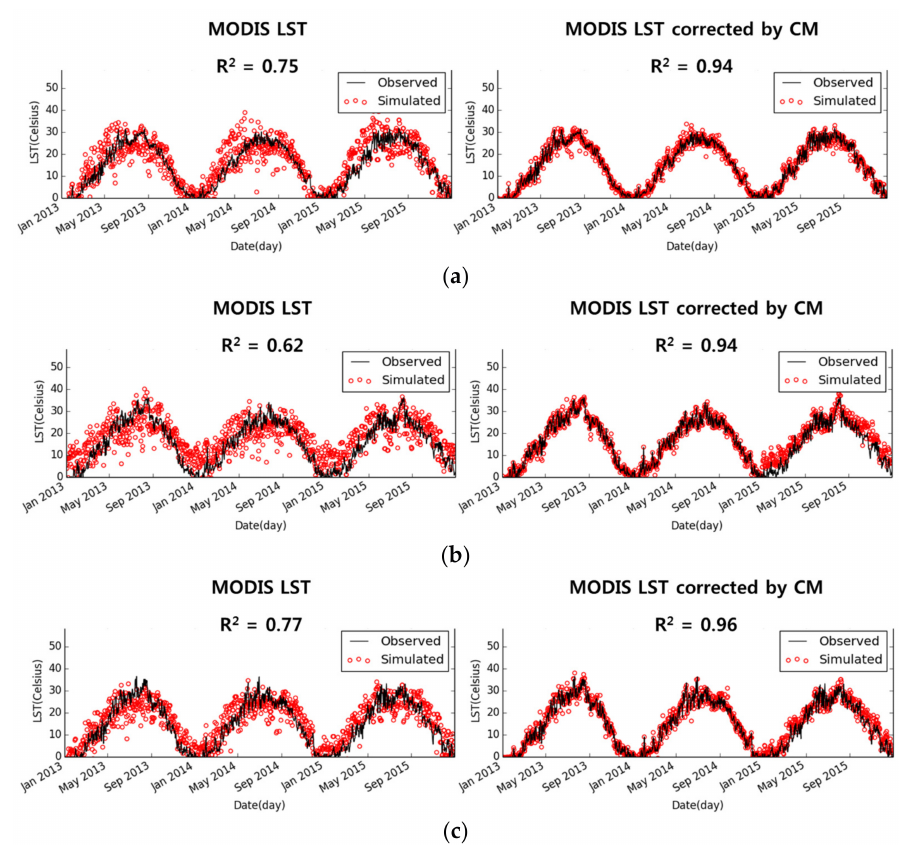
Figure 6. Comparison of observed and simulated LST graphs at verified stations: ( a ) 129 sites; ( b ) 192 sites; and ( c ) 238 sites. The left graphs are the original MODIS LST values. The right graphs are the corrected MODIS LST values after applying conditional merging